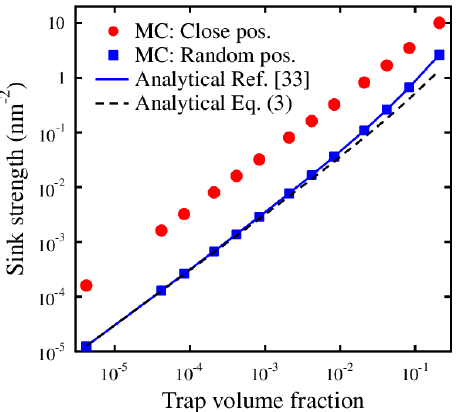
Figure 1. The sink strengths for spherical traps calculated by Monte Carlo (MC) and analytical methods. The position for the defect in the simulation cell is either random or at a close distance (0.05 nm) from a trap boundary. The sink strength for defects with close to trap initial position is greatly enhanced compared to the ones with the random initial